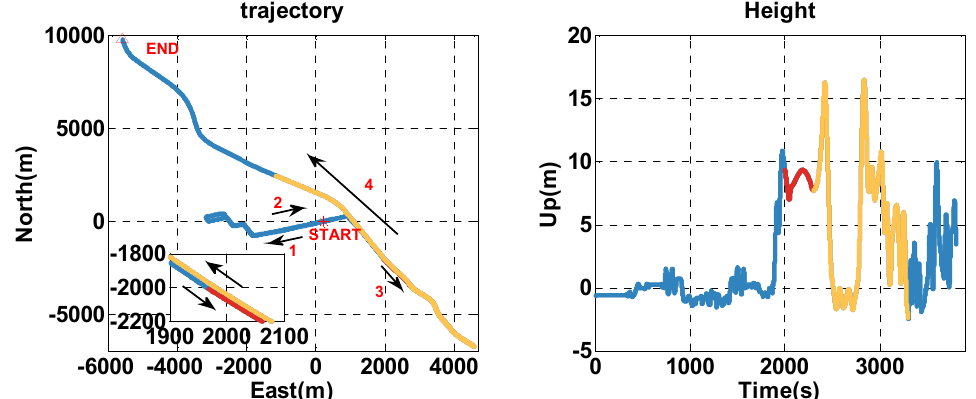
Figure 12. The horizontal trajectory and height of the real-device test. The blue, red, and yellow lines indicate the open-sky, insufficient satellite, and satellite outage parts, respectively.